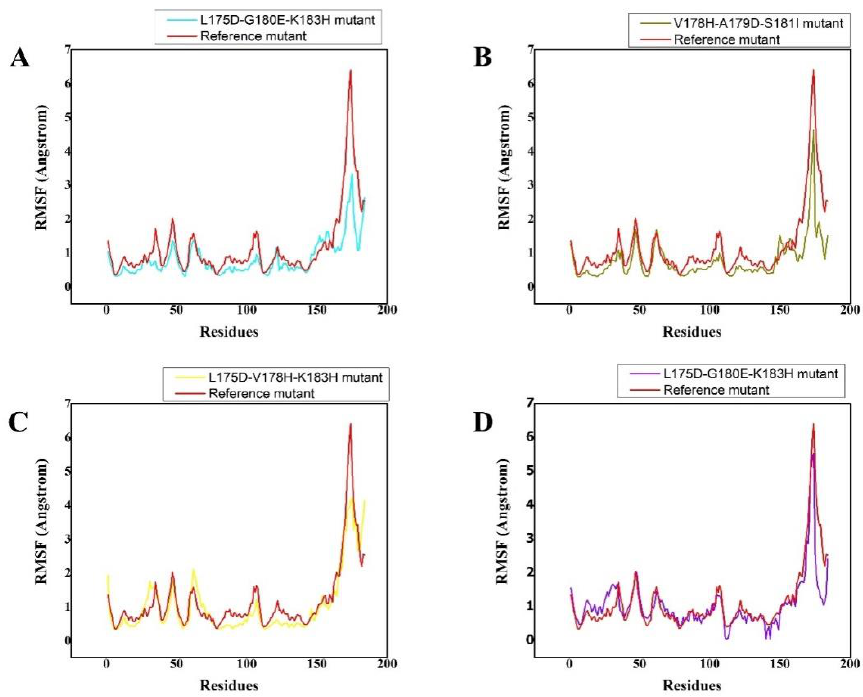
Figure 2. ( A – D ) The RMSF of reference peptide/K-Ras mutant complex (red) and its derivative peptide/K-Ras mutant complexes (cyan, olive green, yellow, and purple, respectively). The X, Y plots show time-dependent RMSF behavior from the initial state to over a 200 ns trajectory of K-Ras in complex with the respectively designed peptide. The different colour scheme shows the differently designed peptides and their respective trajectories as well as the residual flexibility of each system. The x -axis shows the number of residues while the y -axis shows RMSF in Angstrom.